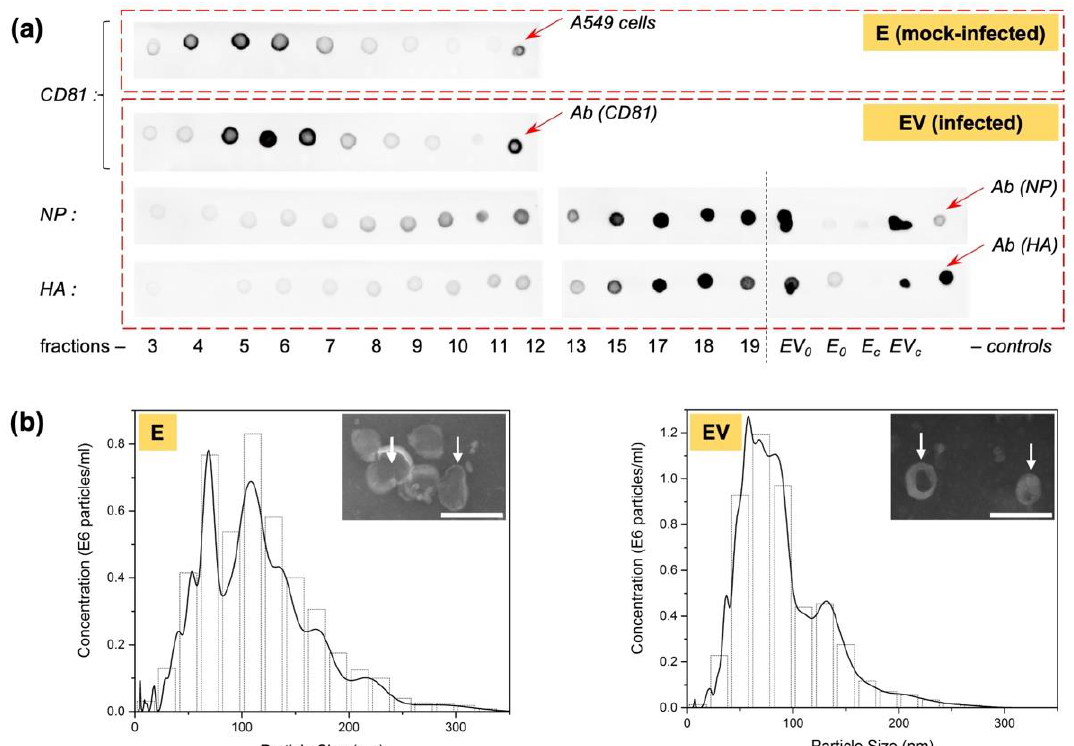
Figure 3. Exosome sample analyses. ( a ) Sucrose gradient fraction (from 3 to 19) dot blot with antibodies to exosome marker protein (CD81) and to IAV structural proteins (nucleoprotein, NP, and haemagglutinin, HA). Positive controls of mock-infected A549 cells, as well as pure antibodies, Ab(CD81), Ab(NP), and Ab(HA), are marked by red arrows. As controls, infected-cell-secreted exosomes before sucrose gradient (EV 0 ) and infected cells (EV c ) were also tested. To check unspecific binding of antibodies to NP and HA used with exosomes from mock-infected cells, exosomes from mock-infected cells before sucrose gradient (E 0 ) and mock-infected cells (E c ) were also tested. ( b ) NTA analysis (left is E exosomes, diameter 116 ± 53 nm; right is EV exosomes, diameter 90 ± 41 nm); and ( b, inset) transmission electron microscopy of pooled fractions (scale bar is 200 nm; white arrows mark some exosomes).